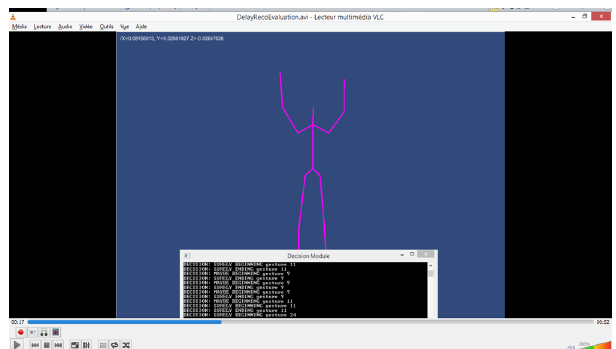
Fig. 4. Gestures recognition video